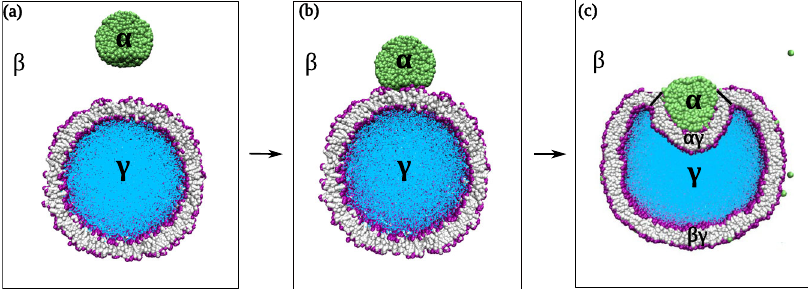
Fig. 1 | Nanovesicle formed by a lipid bilayer withpurple headgroups and gray hydrocarbon chains. The vesicle encloses the aqueous solution γ (blue) and interacts with the liquid nanodroplet α (green). Both the nanodroplet and the nanovesicle are immersed in the aqueous bulk phase β (white): a Initially, the dropletiswellseparatedfromthevesiclewhichimpliesthattheouterlea fl etofthe bilayer is only in contact with the β phase. In this situation, both the nanodroplet andthenanovesiclehaveasphericalshape; b Whenthedropletisattractedtowards